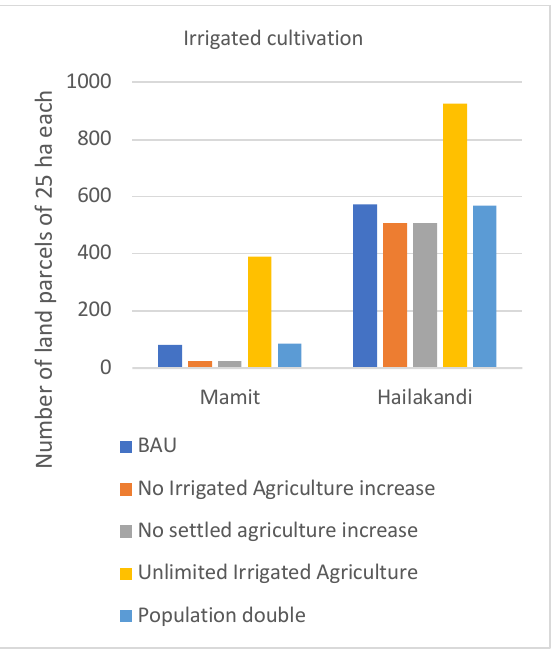
Figure 11. Changes in irrigated cultivation over different